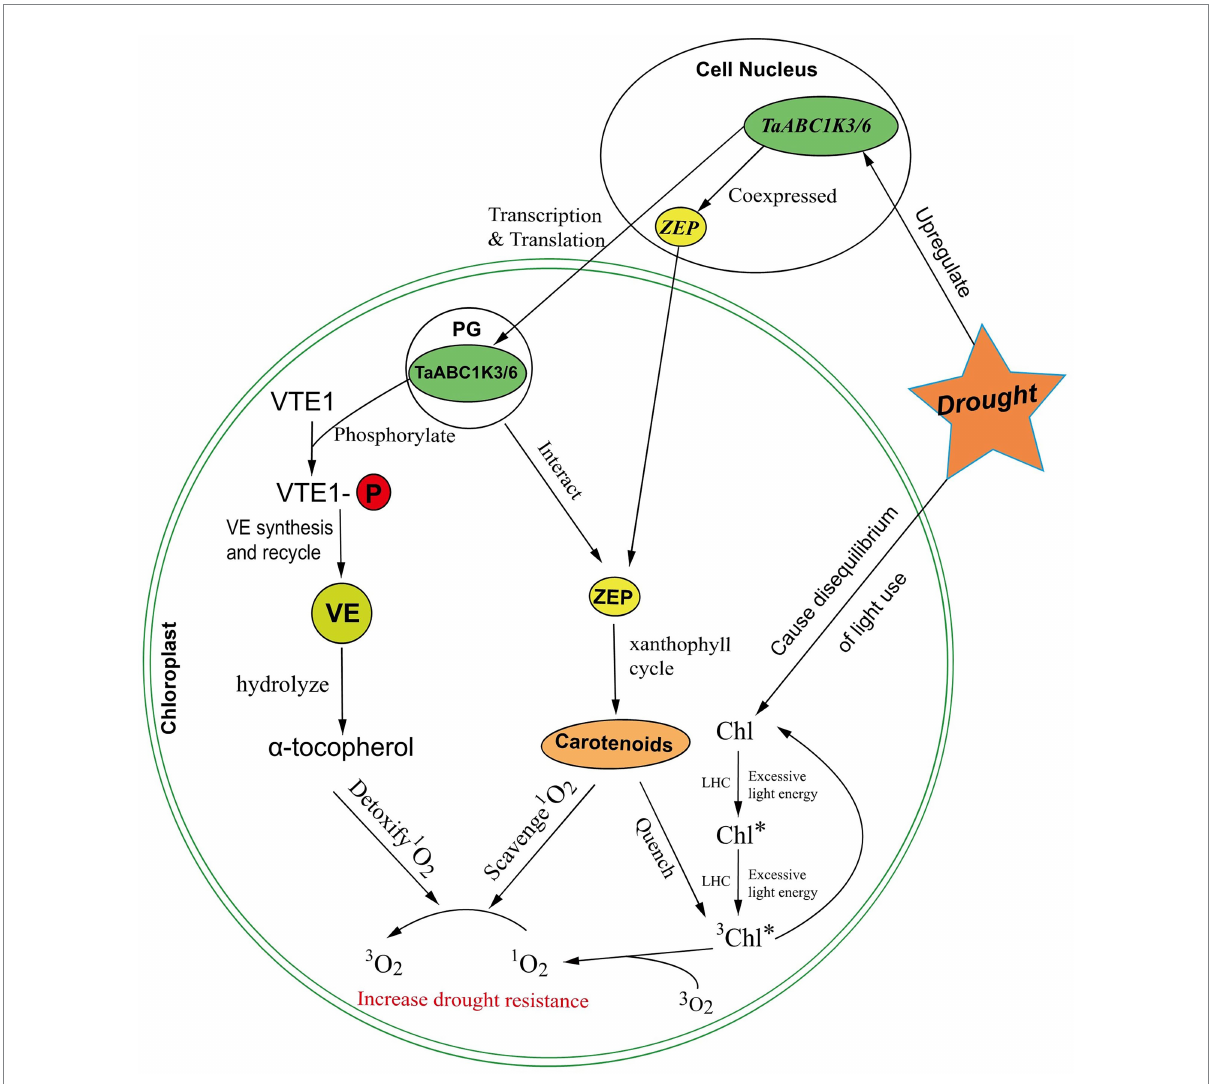
FIGURE 11 A putative regulated network of TaABC1K3 and TaABC1K6 in response to abiotic stress in wheat chloroplast. Symbols: PG, plastoglobuli; LHC, light-harvesting complex; ZEP, zeaxanthin epoxidase; VTE1, tocopherol cyclase; VE, vitamin E.